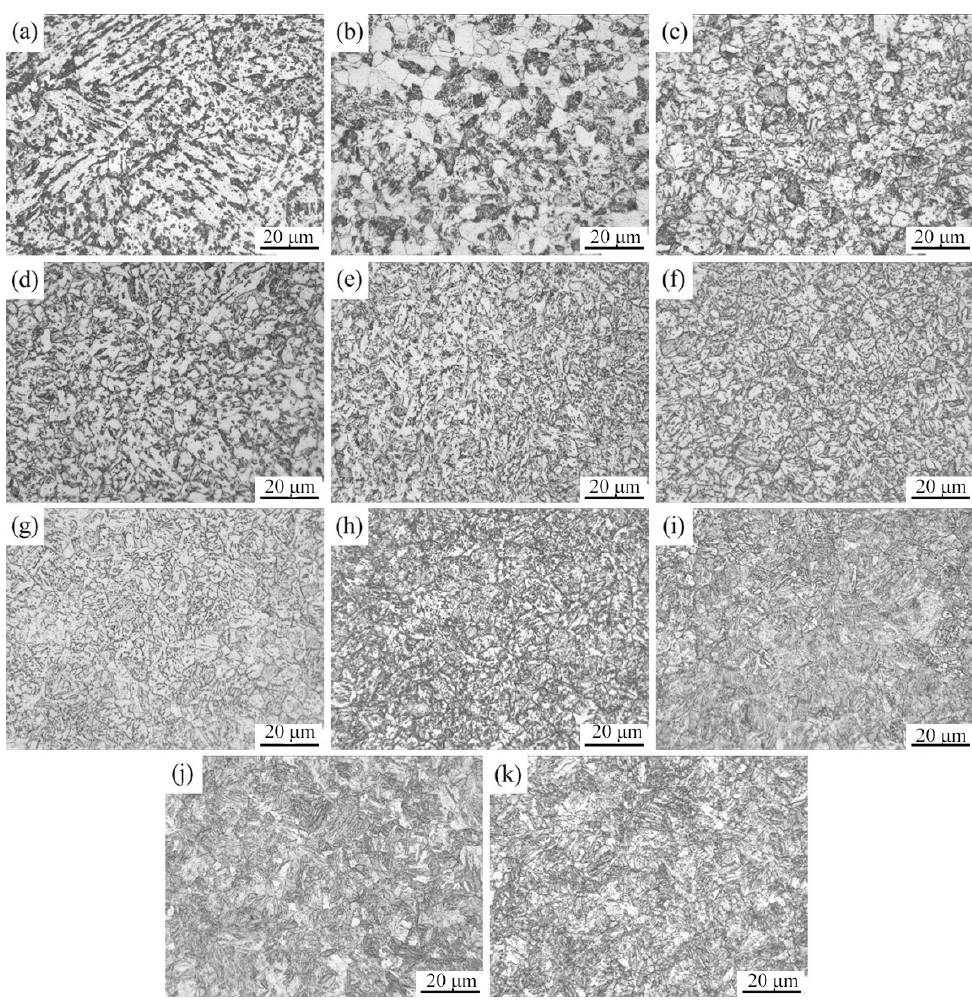
Figure 10. Microstructures of the quenched specimens at different cooling rates ( a ) original micro- structure; ( b ) 0.05 °C·s − 1 ; ( c ) 0.1 °C·s − 1 ; ( d ) 0.6 °C·s − 1 ; ( e ) 1 °C·s − 1 ; ( f ) 2 °C·s − 1 ; ( g ) 3 °C·s − 1 ; ( h ) 5 °C·s − 1 ; ( i )